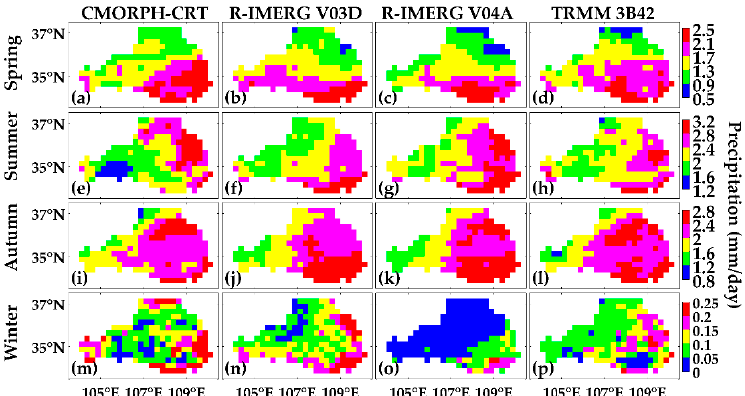
Figure 13. Maps of seasonal daily average precipitation (mm/day) at 0.25° resolution derived from CMORPH-CRT ( a , e , i , m ), R-IMERG V03D ( b , f , j , n ), R-IMERG V04A ( c , g , k , o ), and TRMM 3B42 ( d , h , l , p ) estimates for spring, summer, autumn and winter (from top to bottom) over the Weihe River Basin between June 2014 and November 2015.